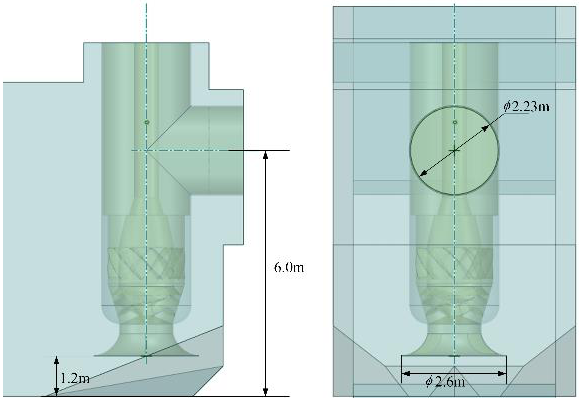
Figure 2. The arrangement of the pump.